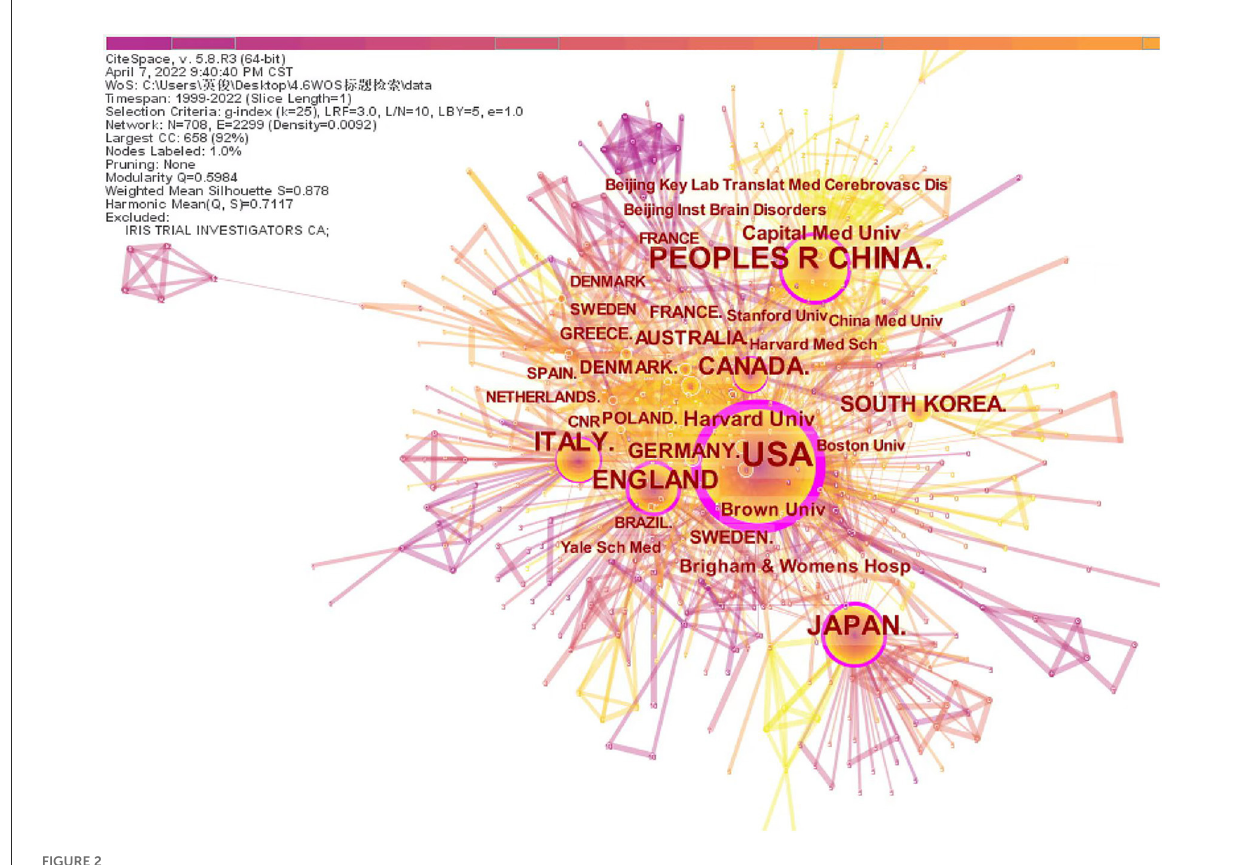
FIGURE2 The network of countries and